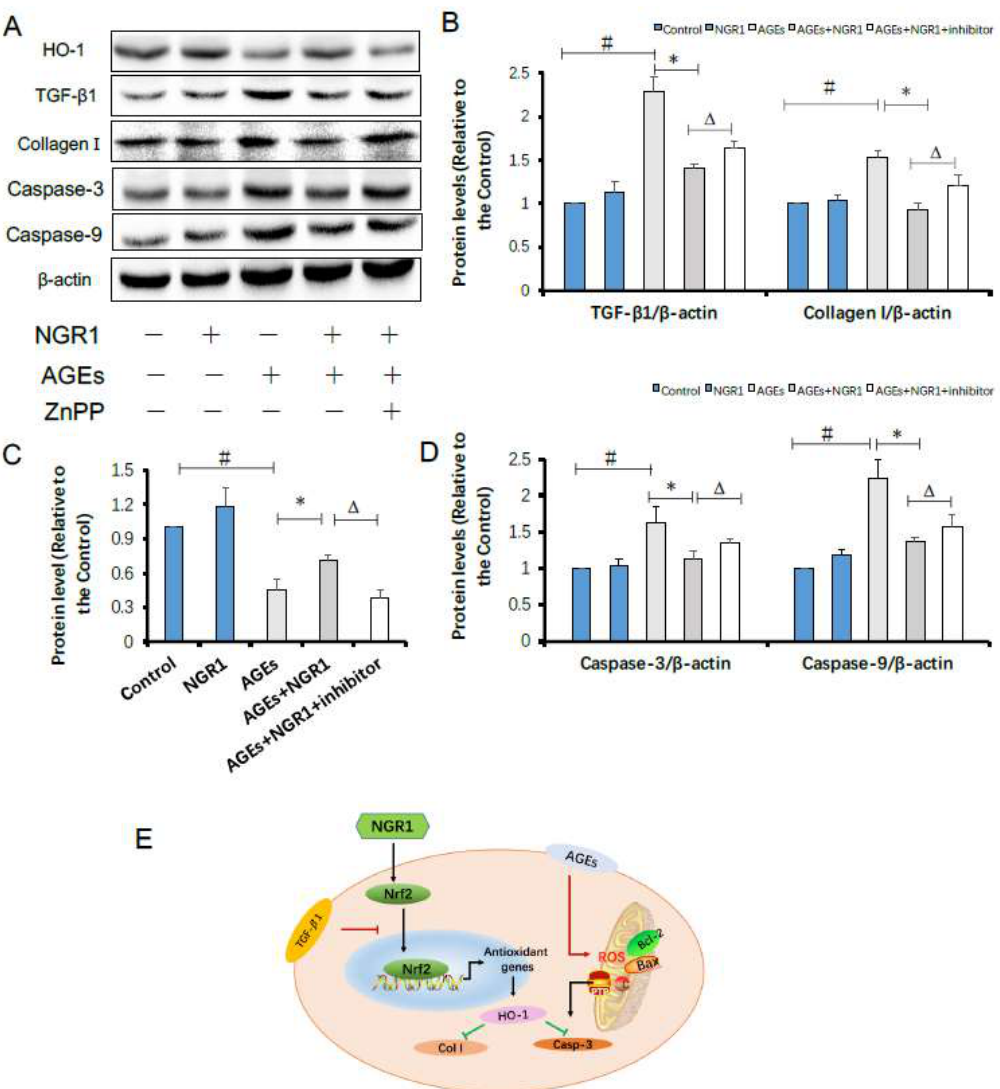
Figure 10. The protective effects of NGR1 on HK-2 cells exposed to AGEs were neutralized by HO-1 inhibitor (zinc protoporphyrin (ZnPP)); ( A ) representative immunoblots of the protein expressions of HO-1, TGF- β 1, collagen I, caspase-3, and caspase-9; ( B – D ) relative expression levels of HO-1, TGF- β 1, collagen I, caspase-3, and caspase-9 compared to β -actin are expressed in the bar graphs. All data